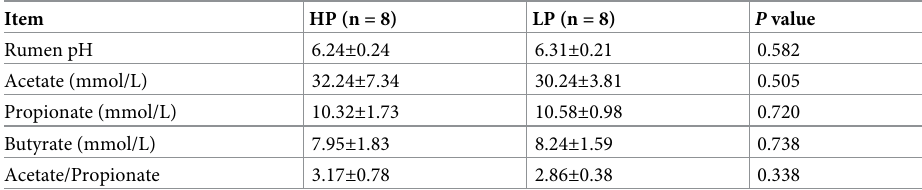
Table 3. Comparison of rumen fermentation parameters between the HP and LP groups.